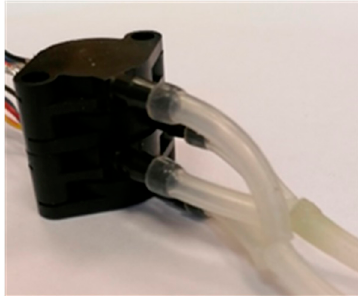
Figure 13. Completed double-membrane sensor.